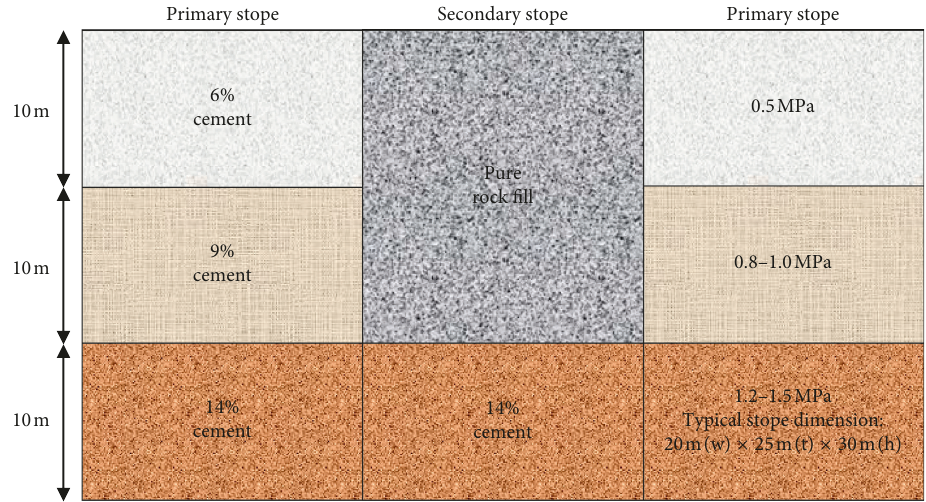
Figure 10: The Jinying Gold Mine backfill strength design to sublevel backfilled for later mining.